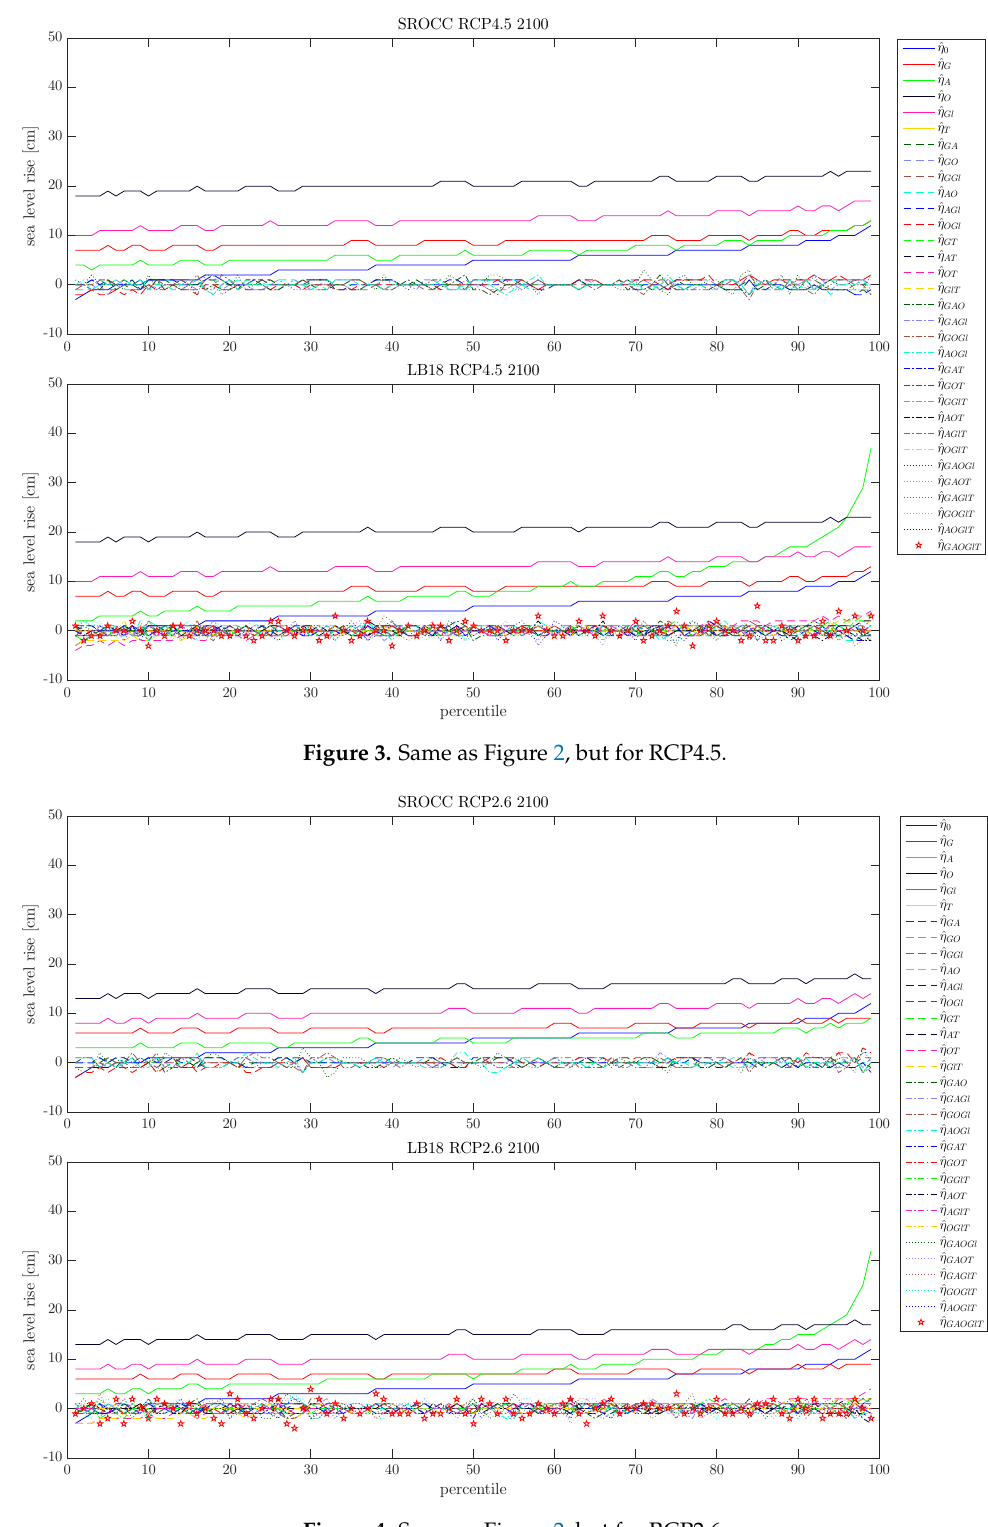
Figure 4. Same as Figure 2, but for